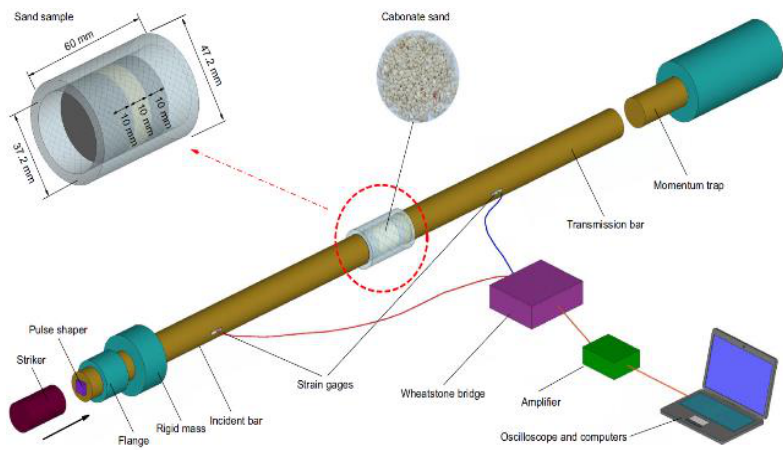
Figure 14. General diagram of SHPB system (reprinted from Ref. [79]).